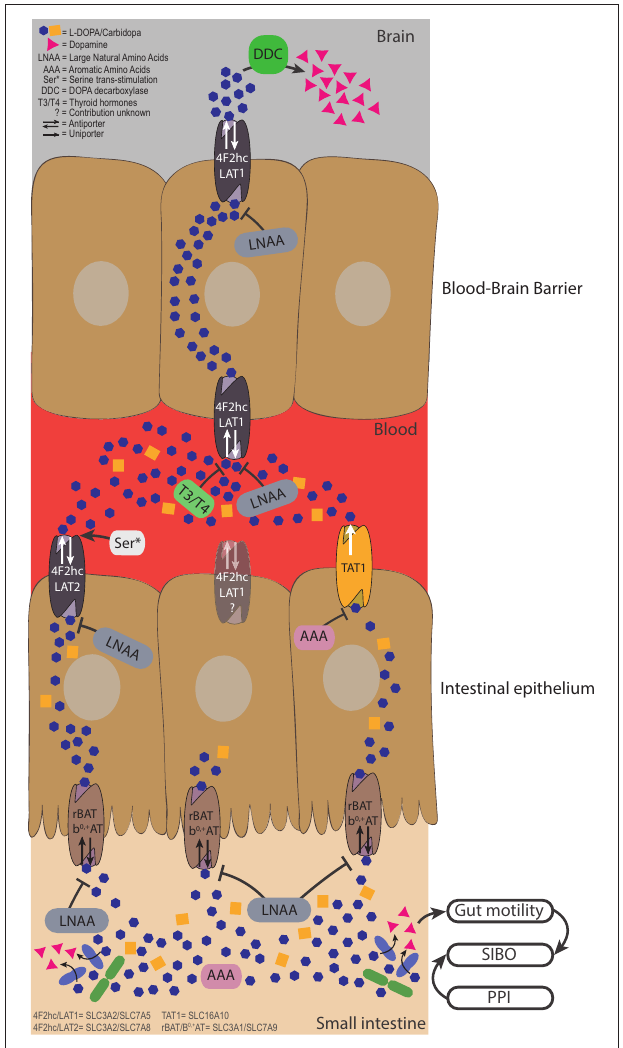
FIGURE 2 | Bacterial degradation and dietary components restrict levodopa transport. Levodopa is taken up in the small intestine by the apical transporter rBAT/b 0, + AT, and is sequentially is transported over the basolateral membrane by 4F2hc/LAT2 and TAT1. The uptake from the lumen can be compromised by LNAAs apically and by LNAAs and AAAs basolaterally. Bacterial degradation can interfere with levodopa before it is transported and elevate levels of dopamine in the lumen. Higher levels of luminal dopamine could affect the gut motility, which, in turn, could result in a state of small intestinal bacterial overgrowth, creating a vicious circle. The fraction of levodopa that ends up in the blood has to be transported over the BBB via 4F2hc/LAT1, which can be compromised by high levels of thyroid hormones (T3/T4), or LNAA. Serine left over from a late proteic meal, can trans-stimulate 4F2hc/LAT2 inducing higher efflux of levodopa in the circulation. Finally, the remaining levodopa will be converted to dopamine in the brain by DDC, to compensate the loss of striatal dopamine levels in PD